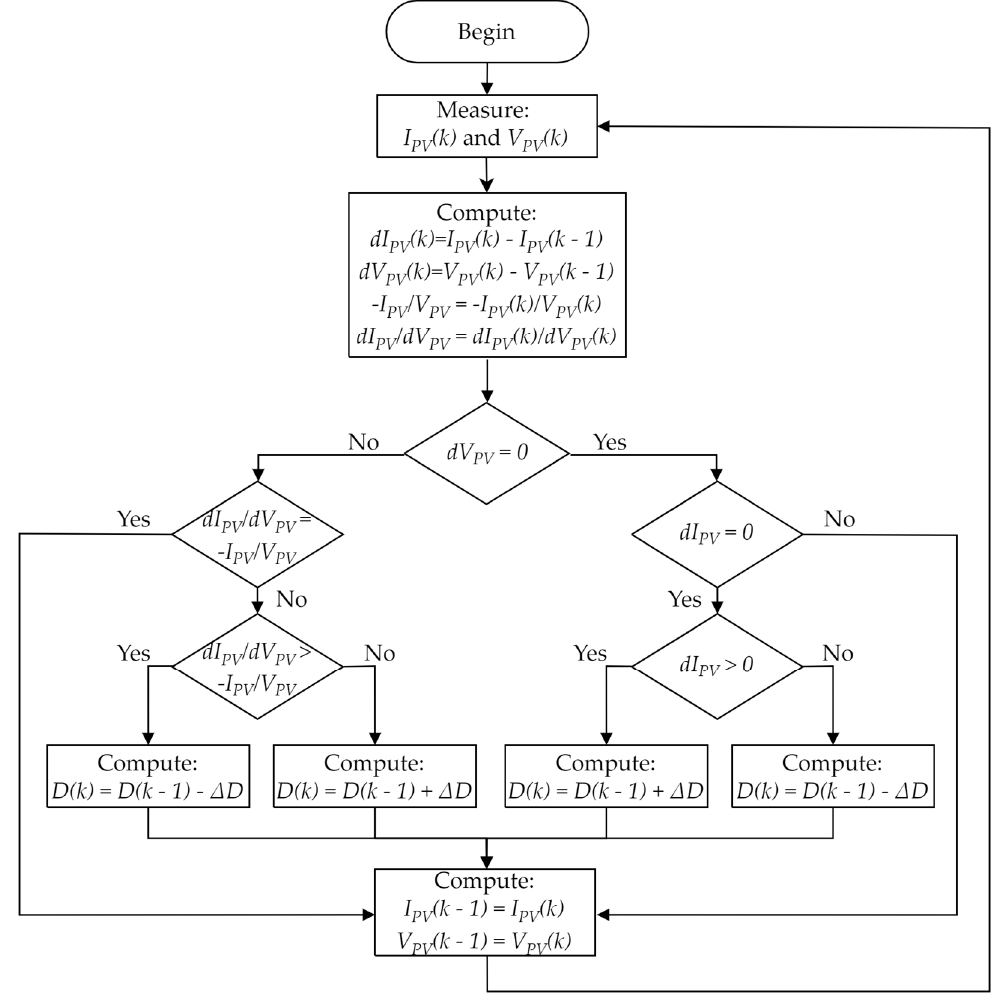
Figure 4. Flowchart of incremental conductance